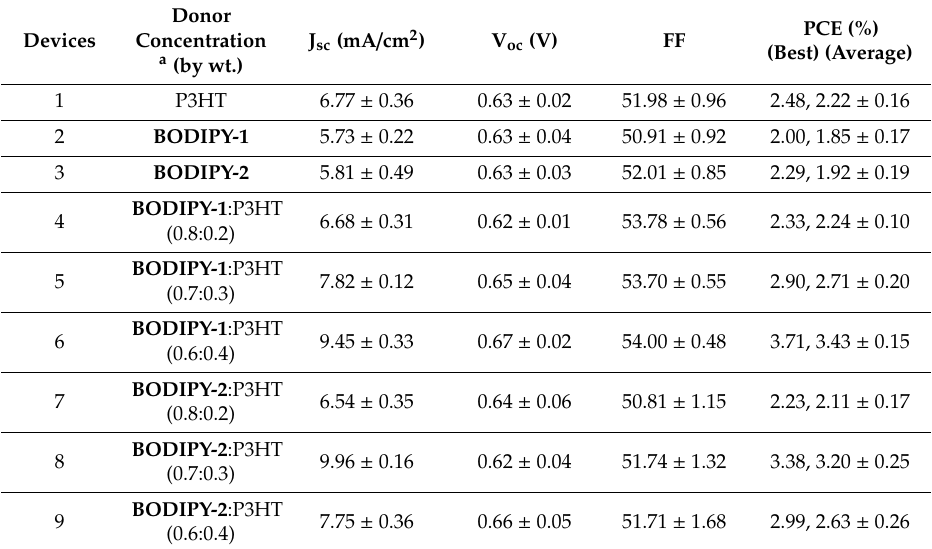
Table 1. Performance parameters of ternary solar cells with BODIPY:P3HT:PCBM.